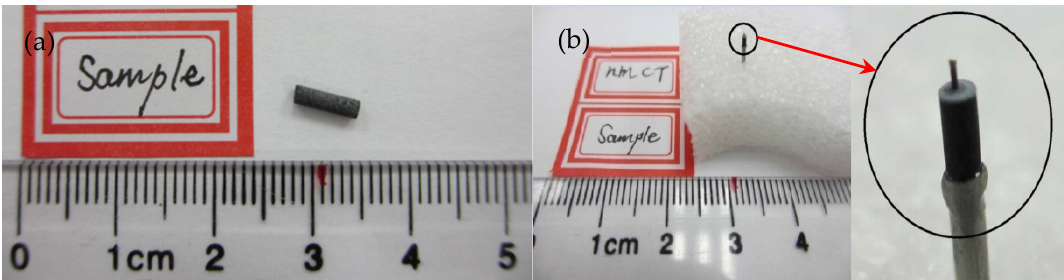
Figure 3. Samples for ( a ) micro-CT and ( b ) nano-CT scanning.